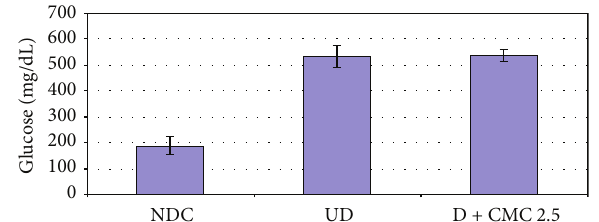
Figure 9: The effect of diabetes and orally administered CMC 2.5 on blood glucose levels. Male Sprague-Dawley rats ( 𝑛 = 6 ) were injected i.v. with streptozotocin (STZ) 70 mg/kg to induce diabetes, as described by us previously. STZ-diabetic rats were daily administered by oral gavage CMC 2.5 (100mg/kg) for 3 weeks. At the end of the treatment protocol, rats were sacrificed by exsanguination; blood samples were then collected and analyzed for blood glucose levels by the blood glucose monitoring system. NDC: nondiabetic control; UD: untreated